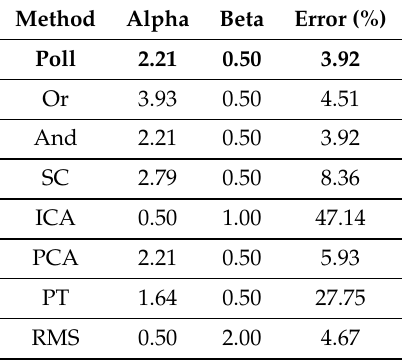
Table 4. Merit figures using the optimal threshold for each method proposed in the vPREDICT database.